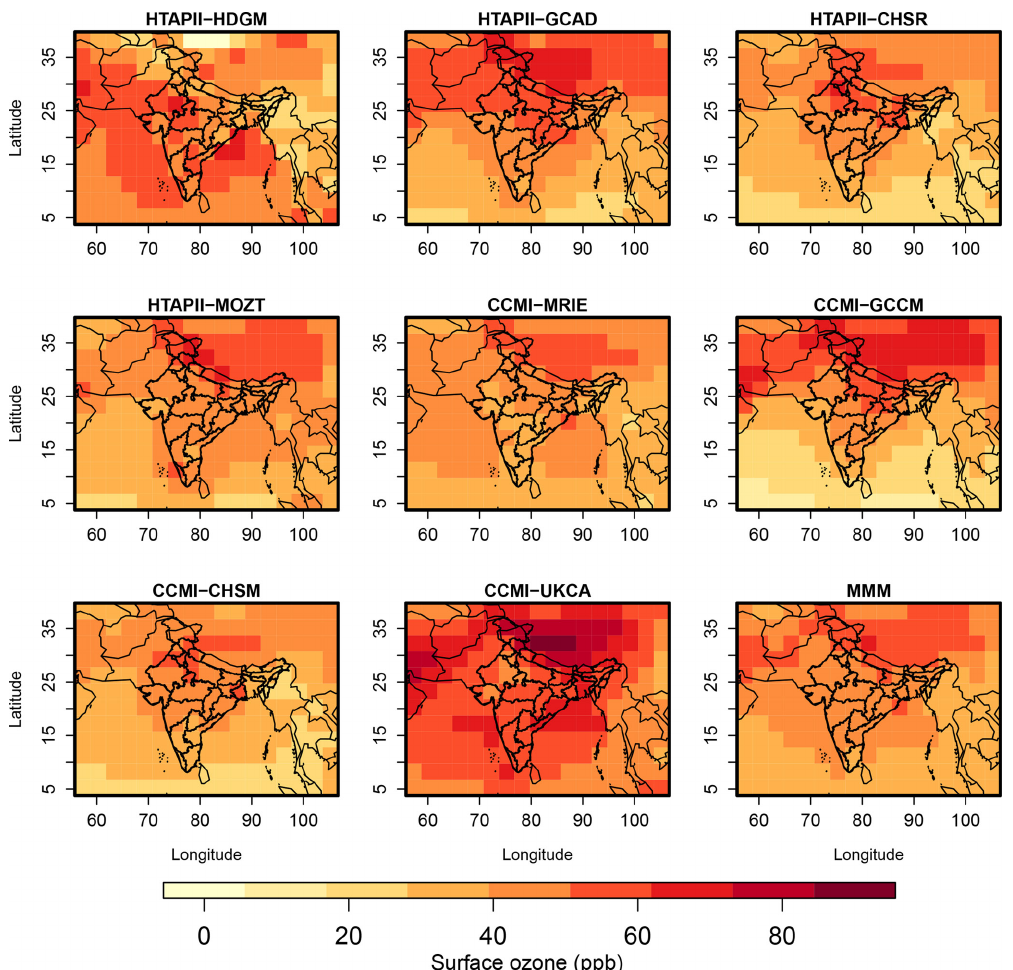
Figure 3. The spatial patterns of annual mean surface ozone (ppb) as simulated by the lowest level in each model, highlighting the regions where the models show maxima and minima over the Indian